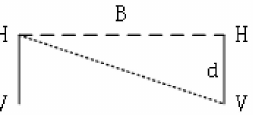
Figure 2. Baseline among different polarization